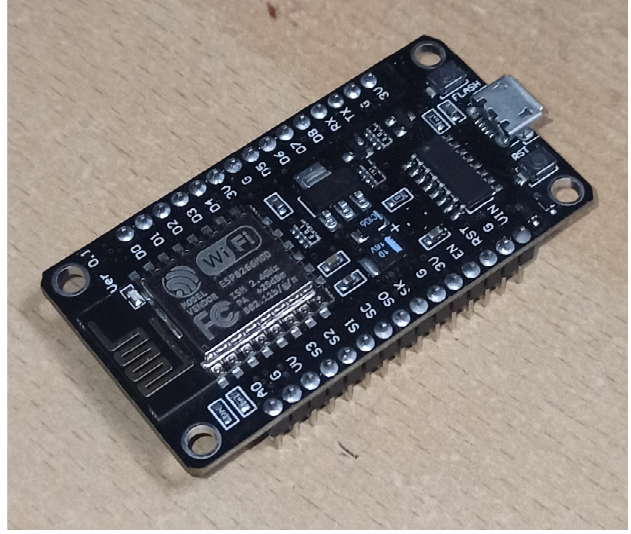
Figure 5. ESP8266, own study A. Wycisk.